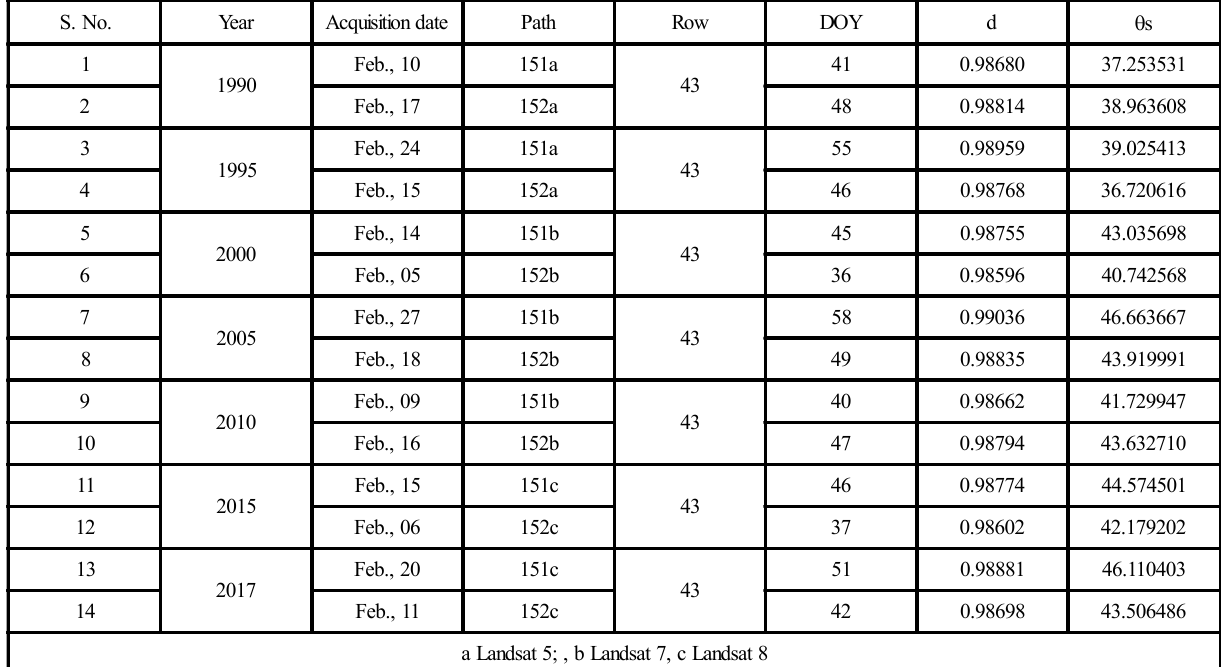
TABLE 1. LANDSAT SATELLITE IMAGERY USED IN THE STUDY